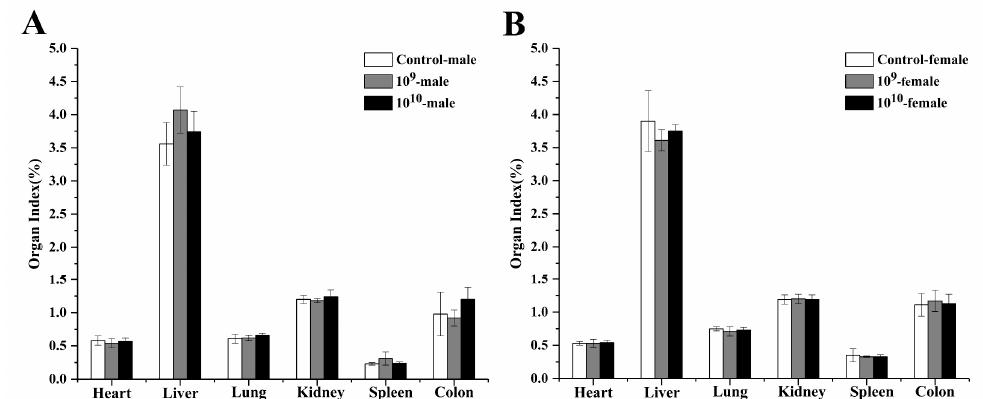
Figure 3. Effect of Blautia producta DSM 2950 on the organ index. ( A ) Organ index of male mice. ( B ) Organ index of female mice. p < 0.05 was considered statistically significant (*), while p < 0.01 was considered extremely statistically significant (**). The results indicated no significant differences among groups.